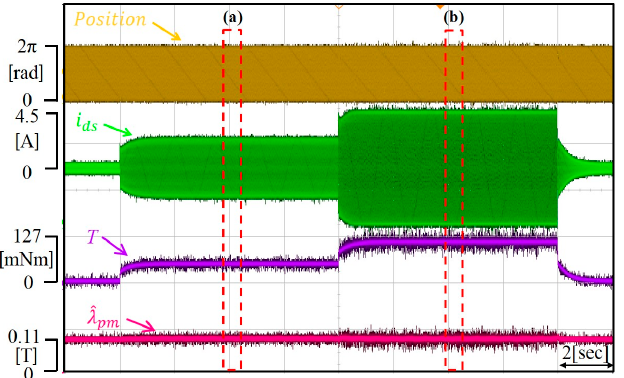
Figure 18. Torque response characteristics of a SPMSM drive in the room temperature with proposed algorithm. (Operating condition: ω r = 620 rad/s, PM temperature = 100 °C).